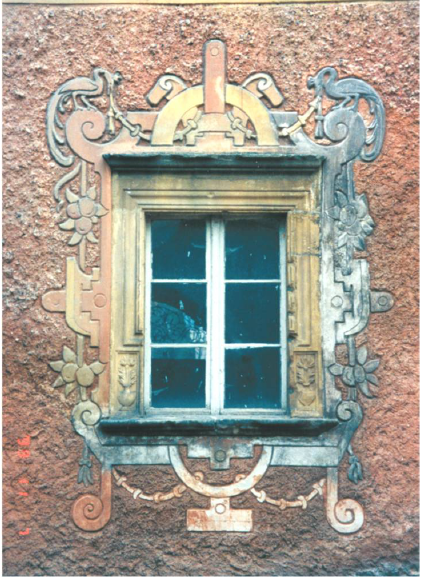
Figure 23. Sgraffito decorations around the windows with a rollwork ornament on the gatehouse of castle Gryf in Zagórze Śląskie. Author’s photo, 2021.